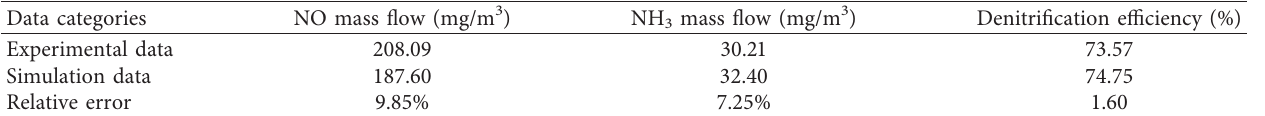
Table 6: Comparison between SNCR simulation value and experiment